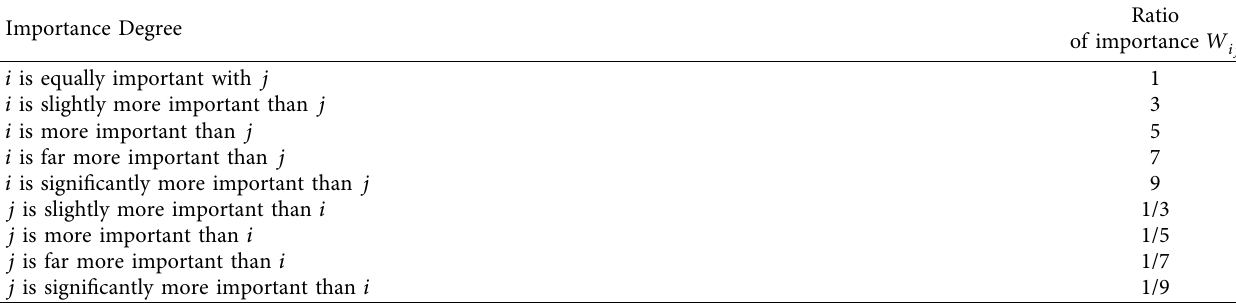
Table 3: Te defnition of the importance scale of the judgment